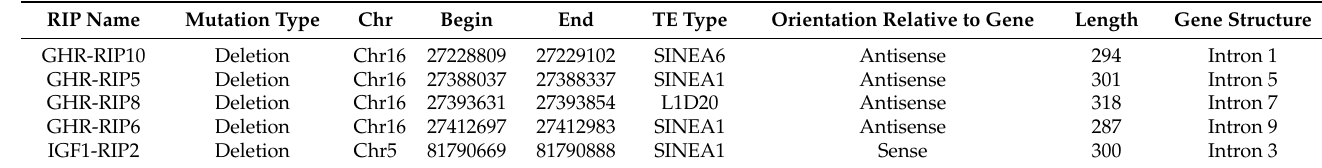
Figure 1. PCR detection of RIPs. 1. Bama miniature, 2. Wuzhishan, 3. Congjiangxiang, 4. Jiangkouluobo, 5. Tibetan, 6. Meishan, 7. Sujiang, 8. Ningxiang, 9. Daweizi, 10. Duroc, 11. Yorkshire, 12. Landrace. M: DNA marker DL2000. Table 2. Genomic information of the identified RIPs by PCR in GHR and IGF1 .